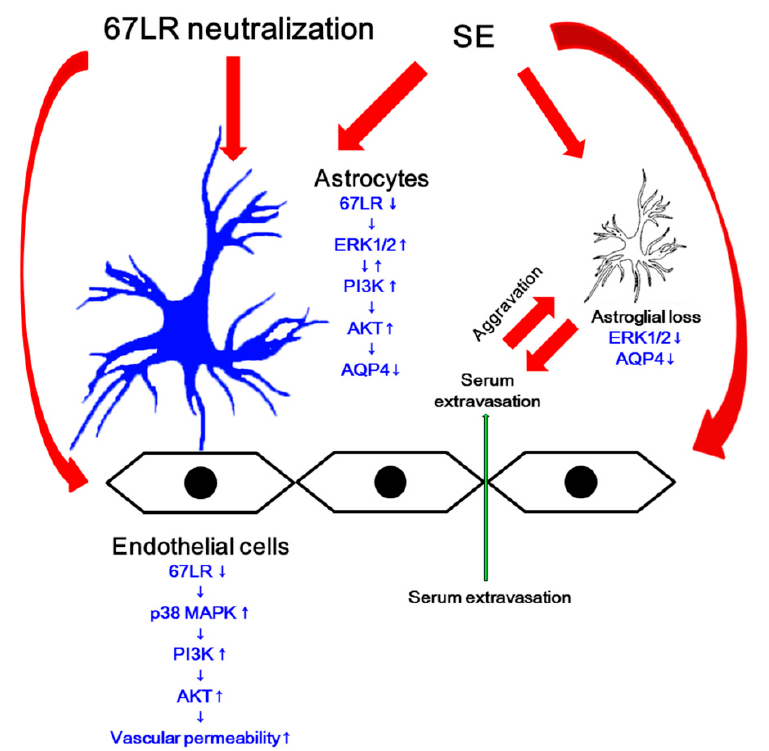
Figure 9. Scheme of role of 67-kDa LR in vasogenic edema formation and AQP4 expression. Blockade of 67LR induced by its neutralization and SE increases p38 MAPK and ERK1/2 phosphorylations in endothelial cells and astrocytes, respectively. Subsequently, both kinases activate PI3K/AKT signaling pathway. Increased AKT activity enhances endothelial permeability and triggers astroglial loss.